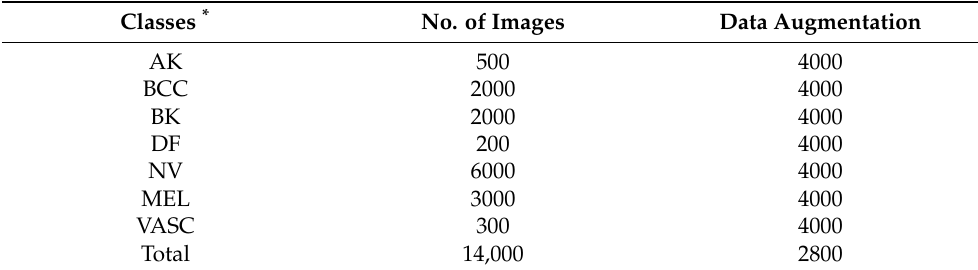
Figure 3. Distribution of samples in the ISIC-2019 and ISIC-2020 datasets according to patients’ history and type of pigmented skin lesions (PSLs). Table 2. Number of images in each class, which were selected from the HAM10000, ISIC-2019, and ISIC-2020 datasets.